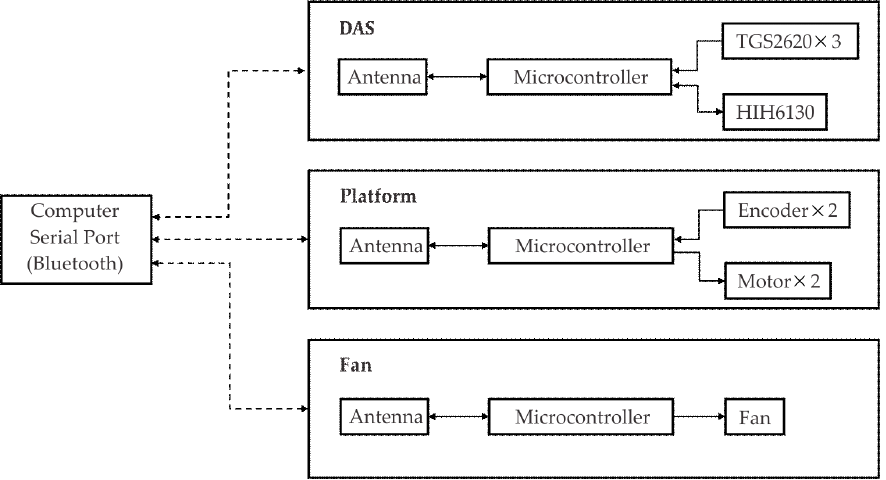
Figure 4. Interaction between the hardware.